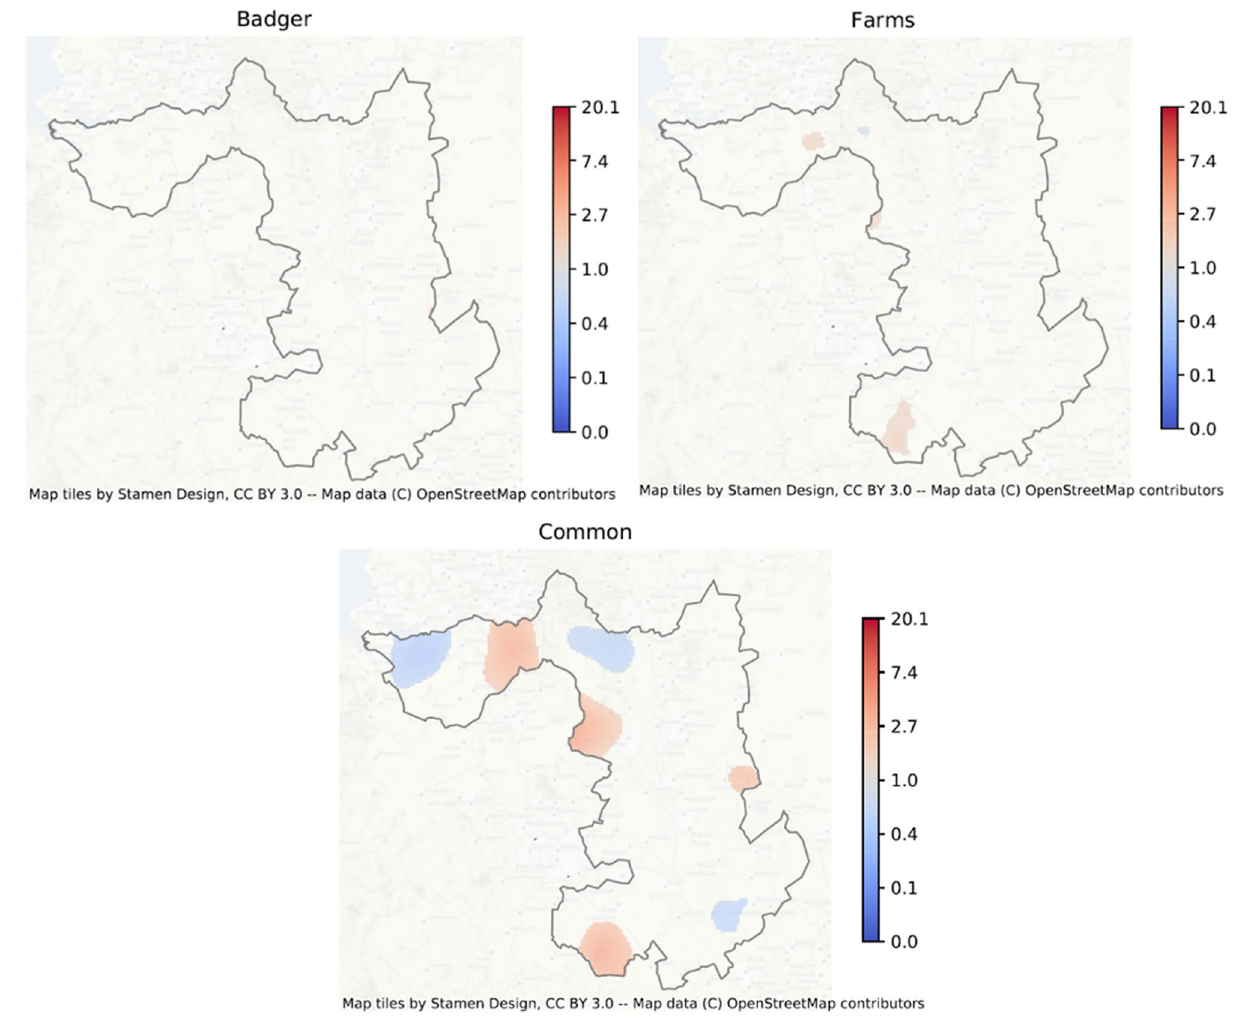
Figure 5. Mean posterior spatial odds ratio of SB0129 in the Edge region, highlighting regions of high posterior confidence that the spatial odds is above or below 1 (Pr(OR > 1) > 0.5 or Pr(OR < 1) > 0.5). The common map indicates high prevalence foci in Cheshire and Derbyshire and east Leicestershire. A small area of additional high prevalence for farms is seen in south west Derbyshire, bordering Staffordshire. No areas of additional high prevalence are seen for badgers. Increase in red represents increased risk. Map tiles by Stamen Design, under CC BY 3.0. Data by OpenStreetMap, under